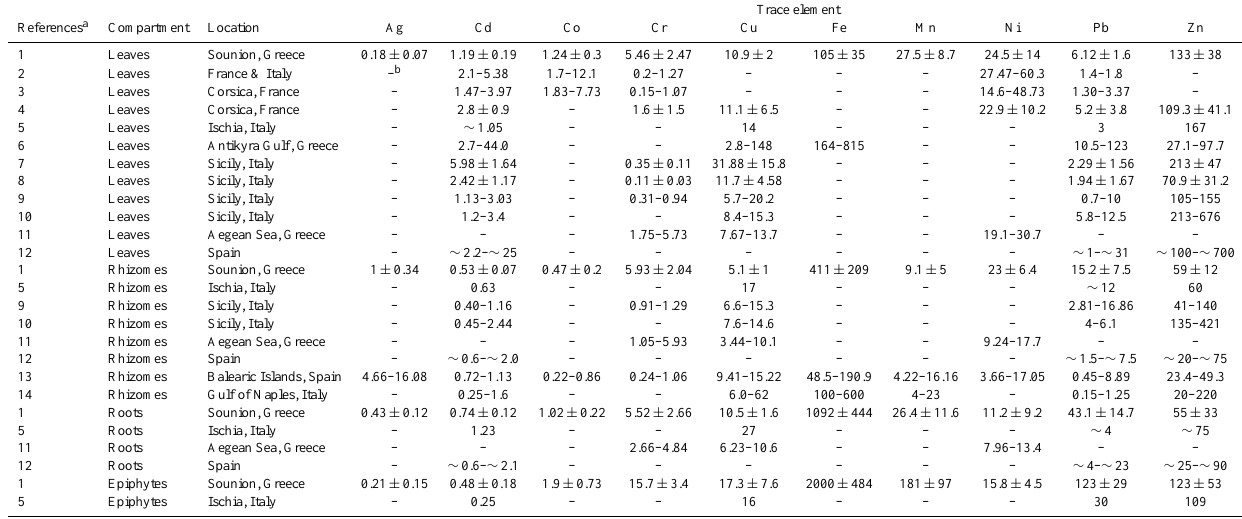
Table 4. Trace element concentration (µgg − 1 drywt) in P. oceanica compartments. Data is given as range of the means, mean ± SD or just the mean, depending on the data availability. The symbol “ ∼ ” indicates that the value is approximated because it was estimated from a